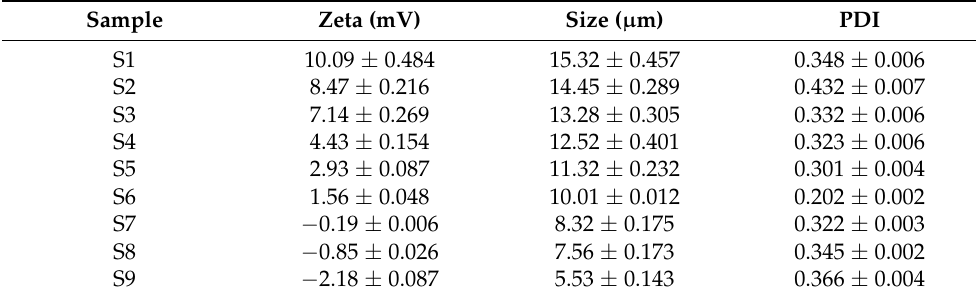
Table 3. Zeta-potential, size, and PDI of particles with different samples ratio of GA and SC.